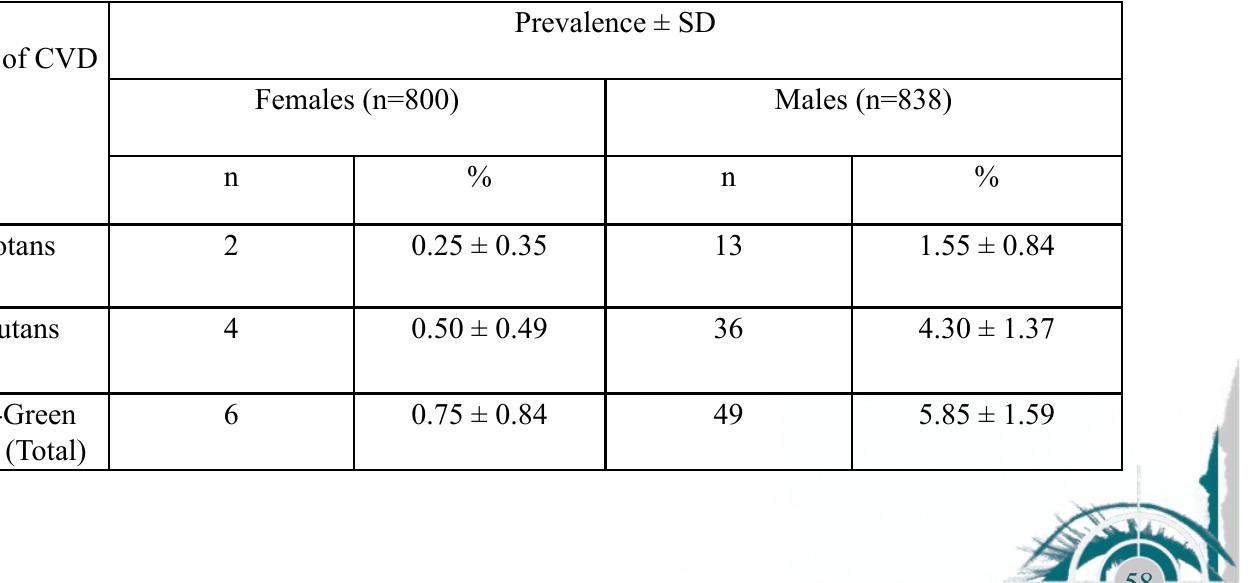
Table 1. The percentage of phenotypic frequency of the different types of red-green colour vision deficiency (CVD) among the participants (n = sample